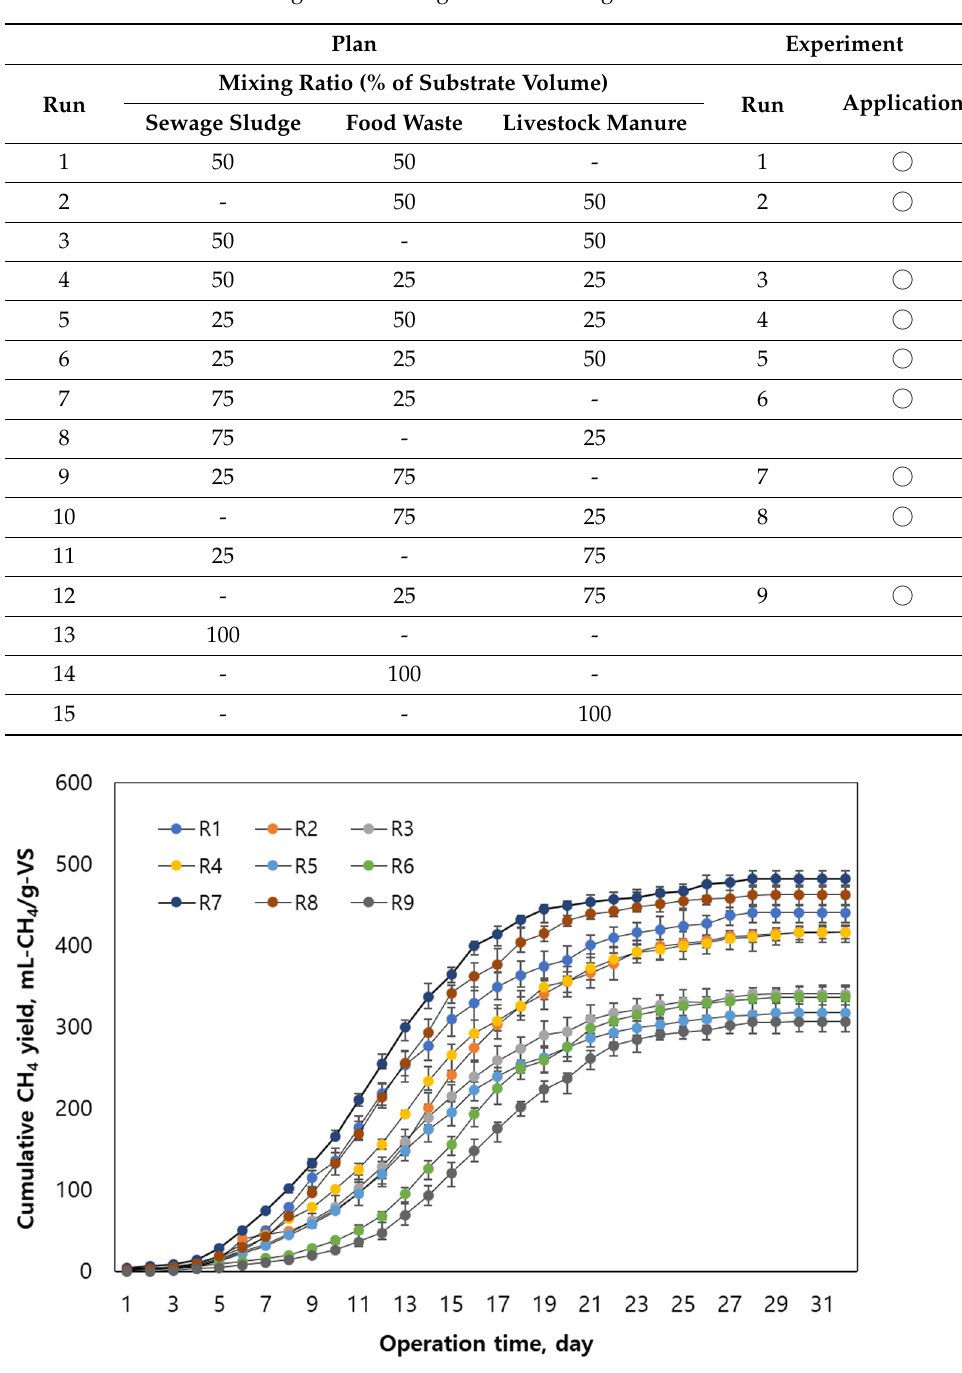
Figure 3. Cumulative methane yield in accordance with various mixing ratios.